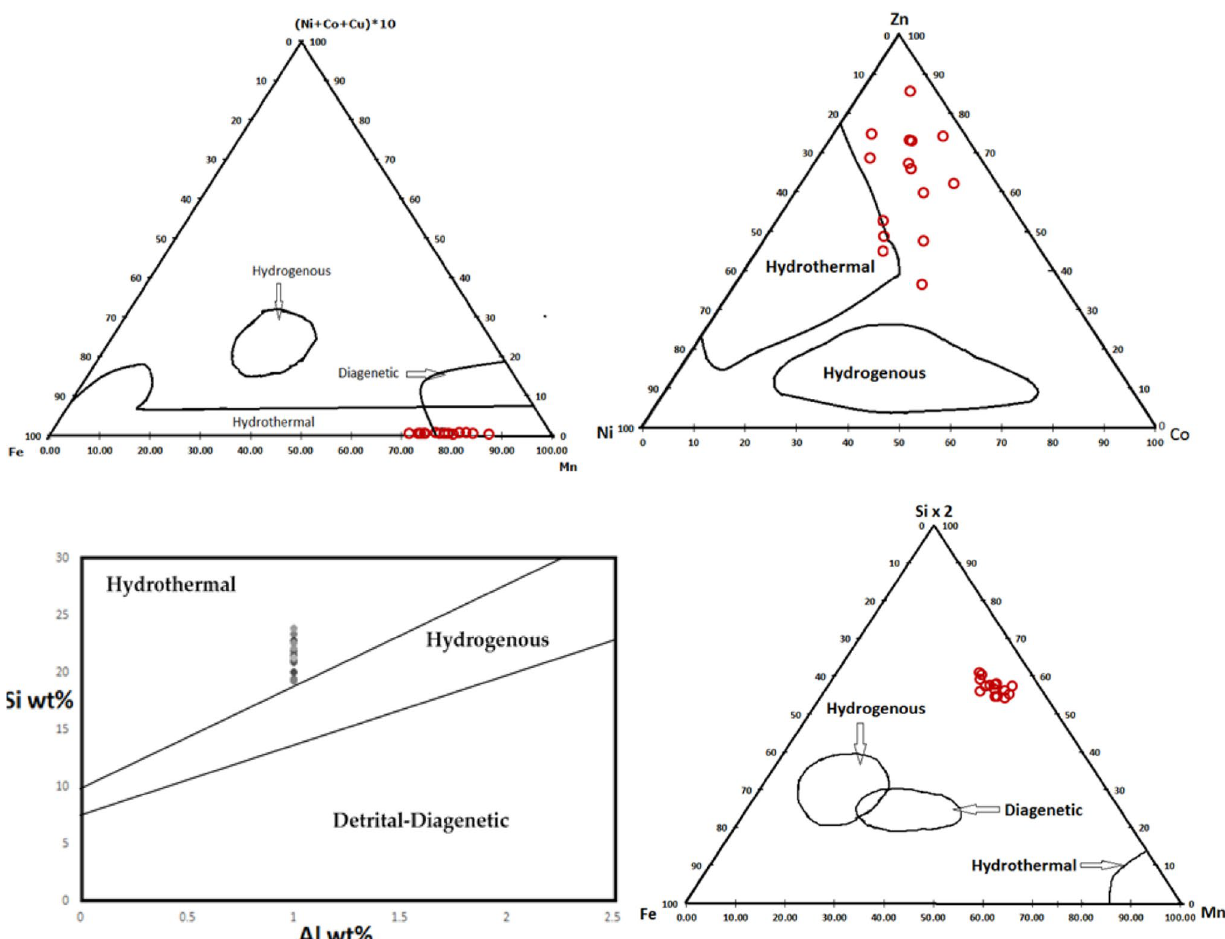
Fig. 7 a – d Fe–(Ni + Co + Cu) × 10–Mn discrimination diagram (Bonatti et al. 1972; Crerar et al. 1982; Hein et al. 1992), b Ni–Zn–Co diagram (Choi and Hariya 1992), c Si/Al diagram (Peters 1988), d Fe–Si × 2–Mn diagram (Toth